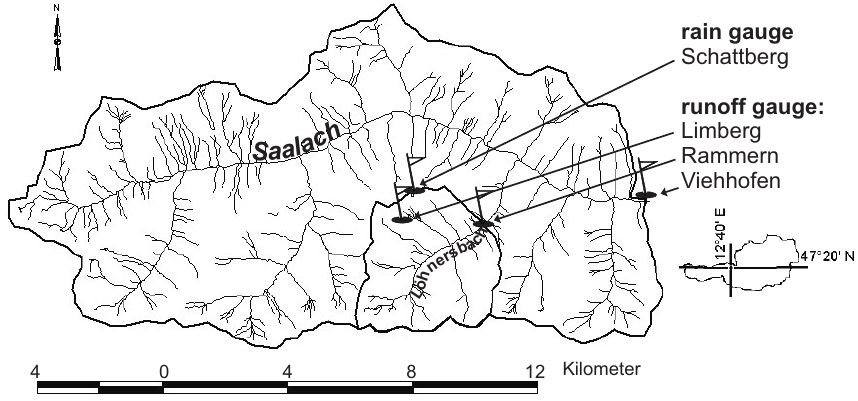
Fig. 1. Map of the nested study area of the upper Saalach basin: upper Saalach (150km 2 , gauge Viehhofen), L¨ohnersbach (15.5km 2 , gauge Rammern), and Limberg (0.07km 2 , gauge Limberg).